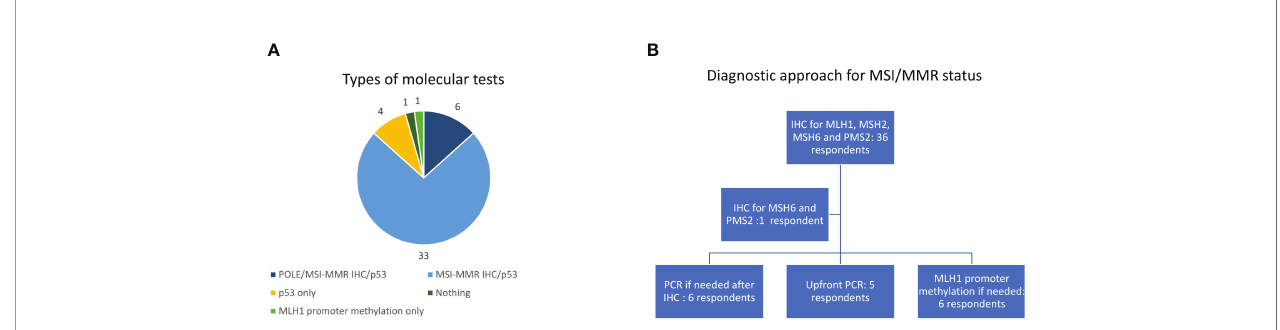
FIGURE 2 | Types of molecular tests (A) and diagnostic approach for MSI/MMR status (B) . IHC, immunohistochemistry; MMR, mismatch repair; MSI, Microsatellite instability; PCR, Polymerase